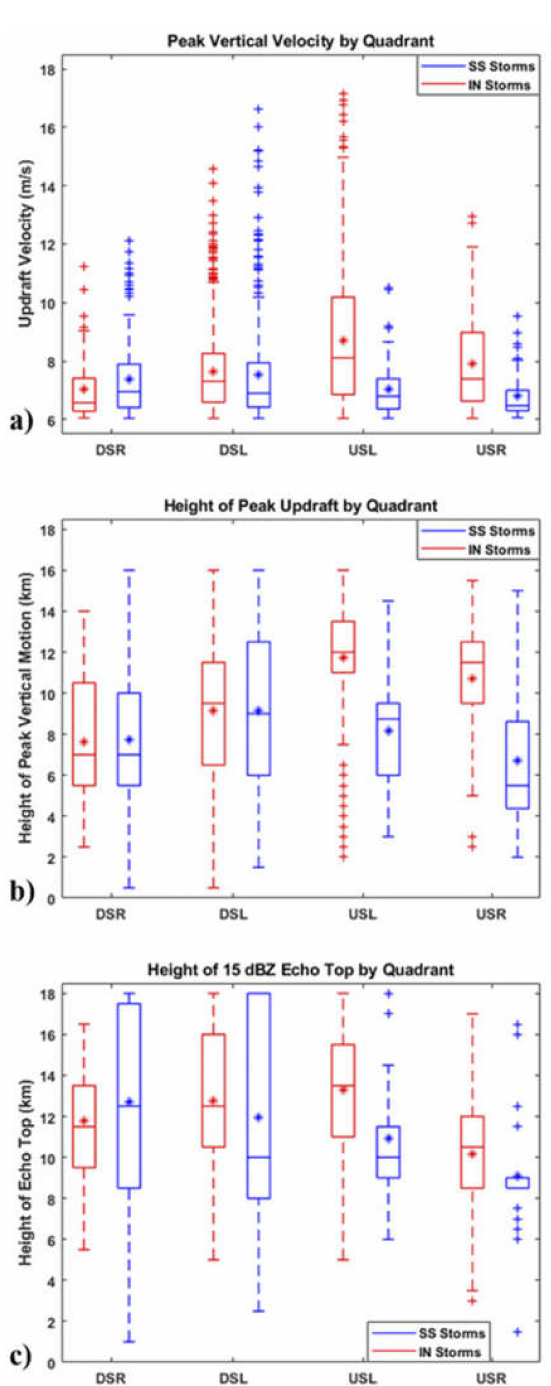
Figure 10. ( a ) Boxplot comparison of the maximum updraft magnitude between the shear-relative quadrants and TC intensity change—intensifying (IN) and steady-state (SS); ( b ) as in ( a ), but for the height of the maximumupdraft; ( c ) as in ( a ), but for the maximum height of the 15-dBZ echo top. In the boxplots, the solid line in the box denotes the median value, while the upper and lower edges of the box represent 75th and 25th quartiles, respectively. The difference between the 75th and 25th percentiles represents the interquartile range (IOR). Whiskers extending above and below the box represent either 1.5 × IOR above the 75th and below the 25th percentiles respectively, or to the maximum/minimum values. Beyond the whiskers, values are statisticaloutliers and are represented as plus signs. Adapted from Wadler et al. (2018)